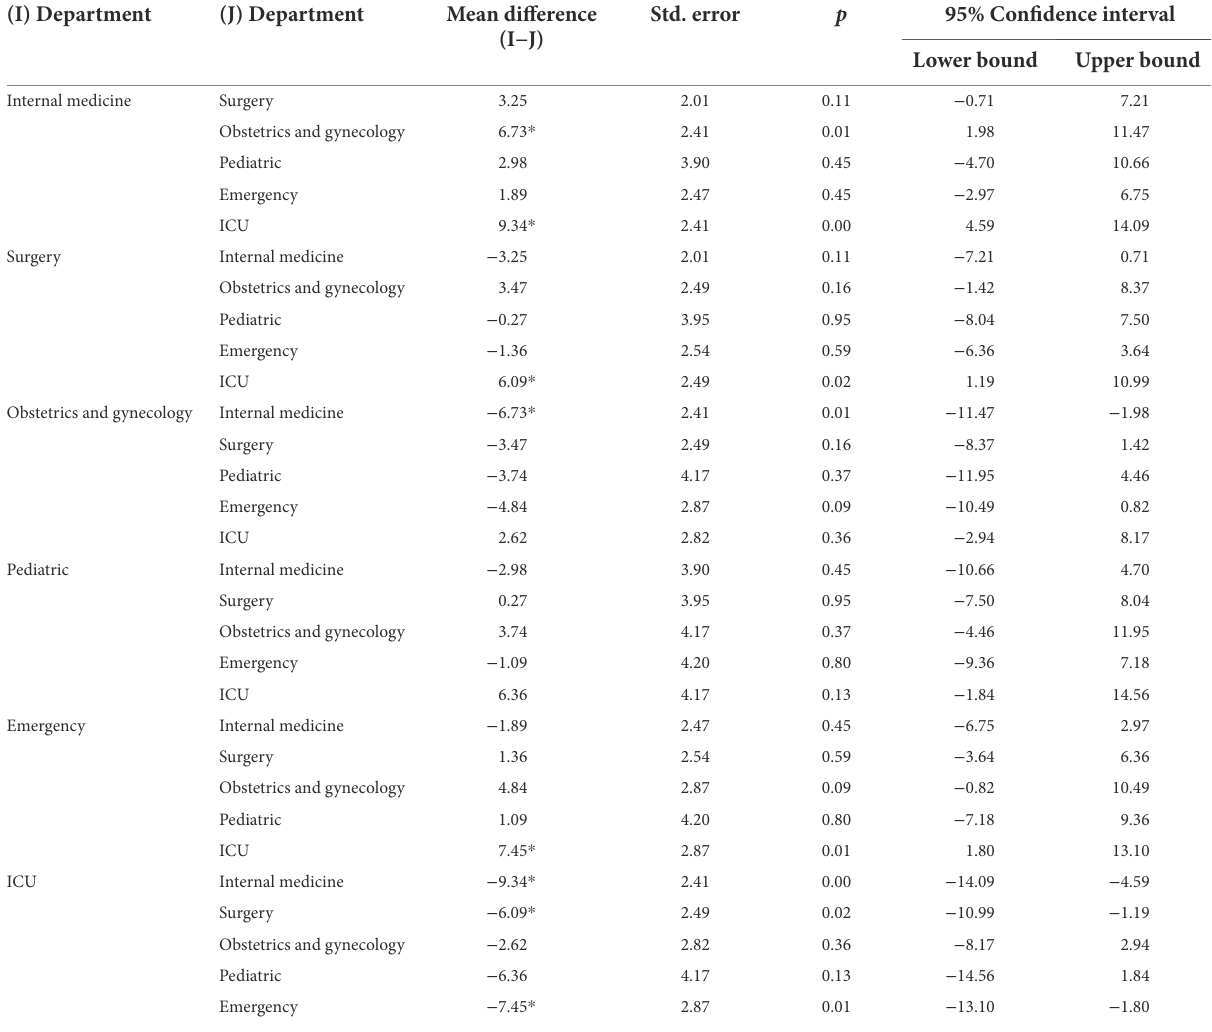
TABLE 4 Multiple comparisons of psychological capital scores among nurses from different